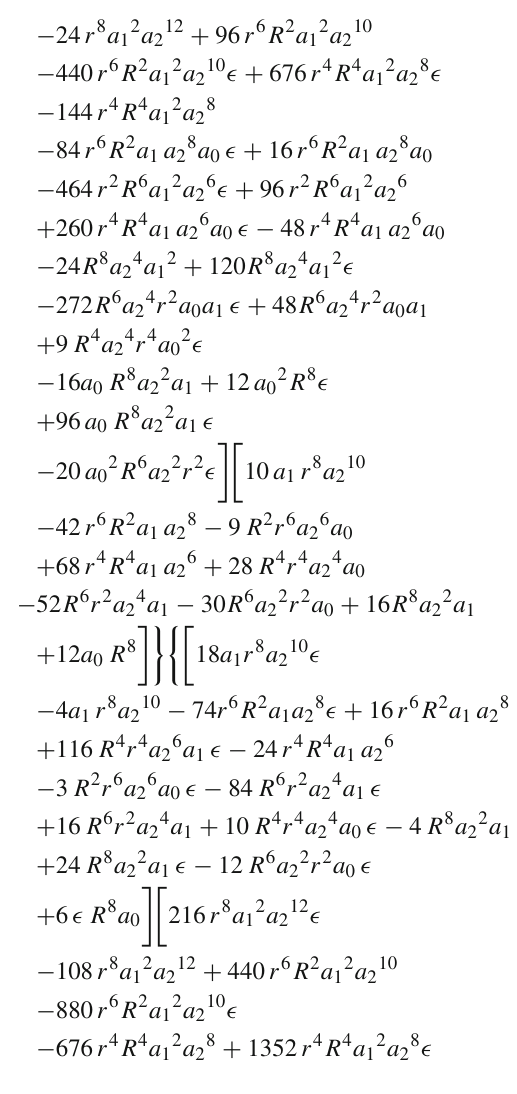
neutral equilibrium value γ = 4 indices have higher values whereas the stability constraints Γ r > γ and Γ > γ are fulfilled everywhere within the pulsar t